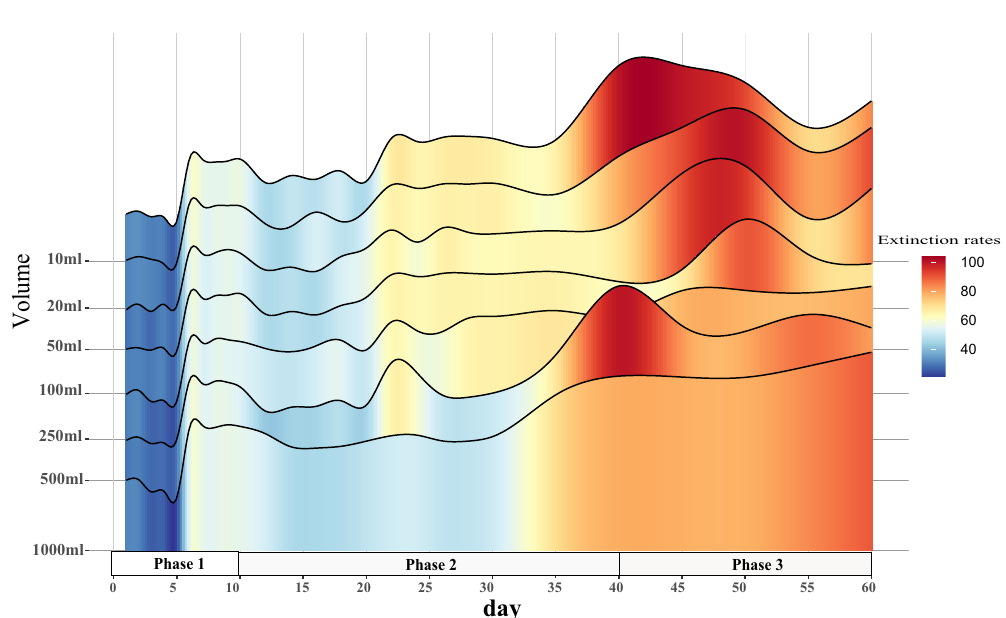
Figure 4. Dynamic change in the extinction rates of microcosm systems. Colours from blue to red represent a low to high extinction